Question: Give a one-sentence summary of this figure.
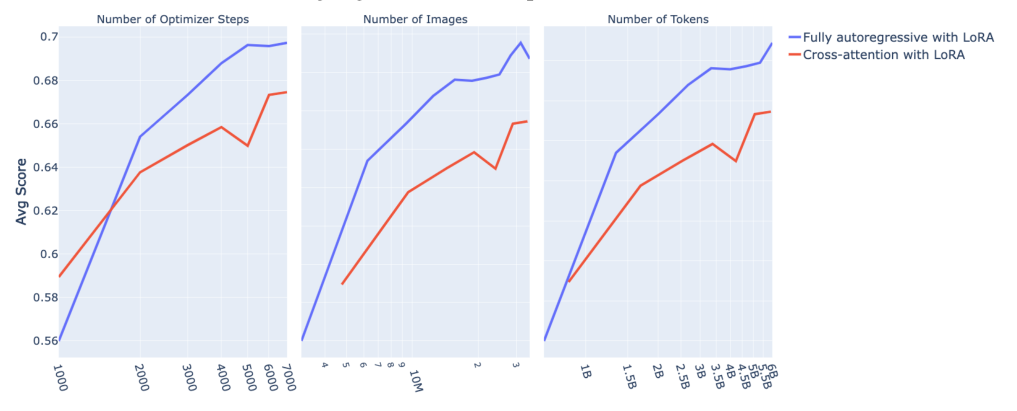
Answer: Comparison of the cross-attention and fully autoregressive architectures through the number of steps, the number of images and the number of text tokens.